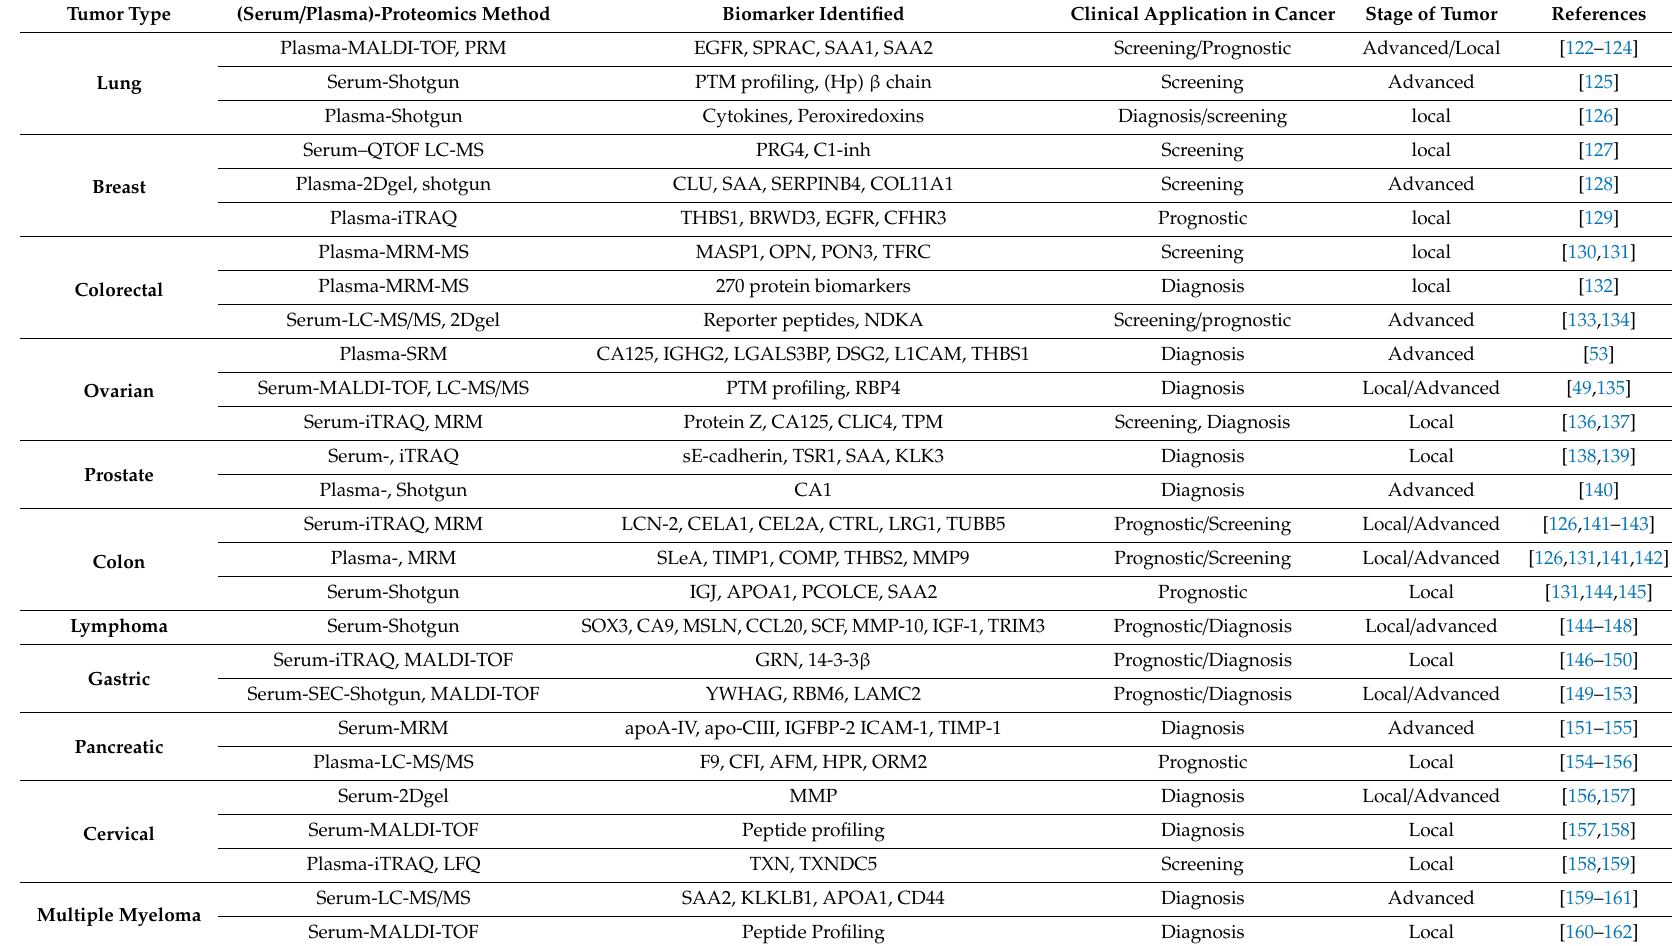
Table 2. Clinical applications of blood-based proteomic profiling in